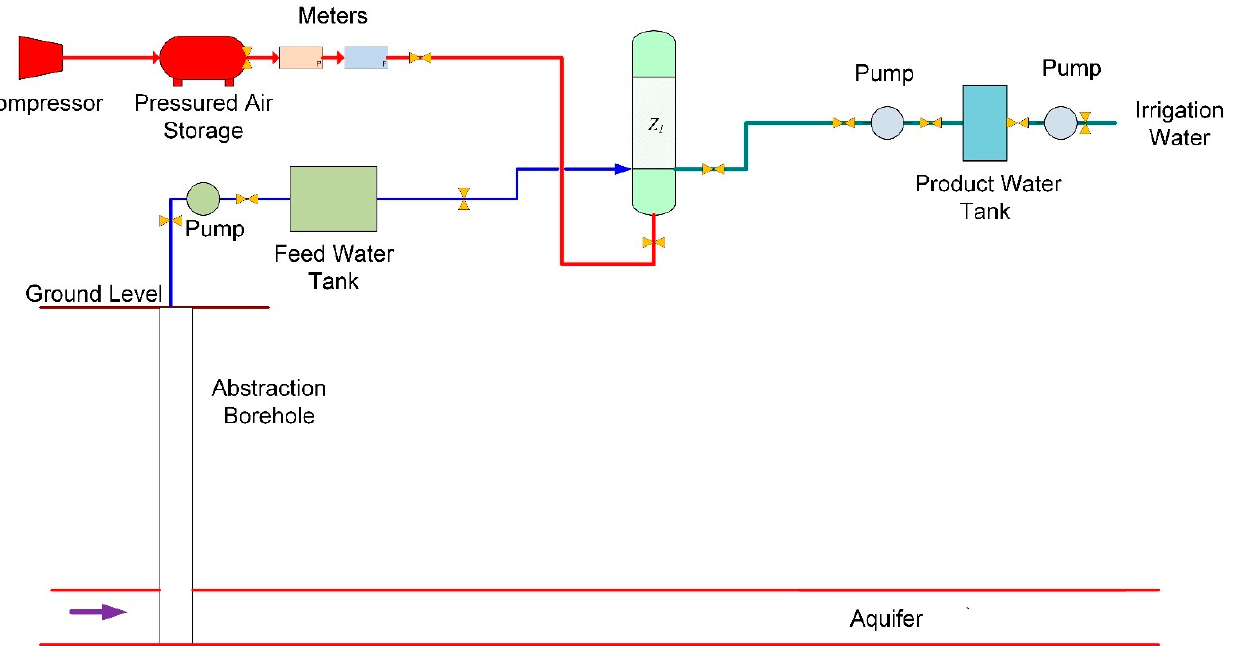
Figure 2. Reactor process flow diagram: Z i indicates presence of a reactor containing a ZVI cartridge, containing 0.4 kg Fe 0 . P = pressure meter; F = flow meter; red flow lines = air; blue flow lines = saline water; green flow lines = partially desalinated water. Reactor size = 0.24 m 3 ; air flow is 60 L h − 1 .